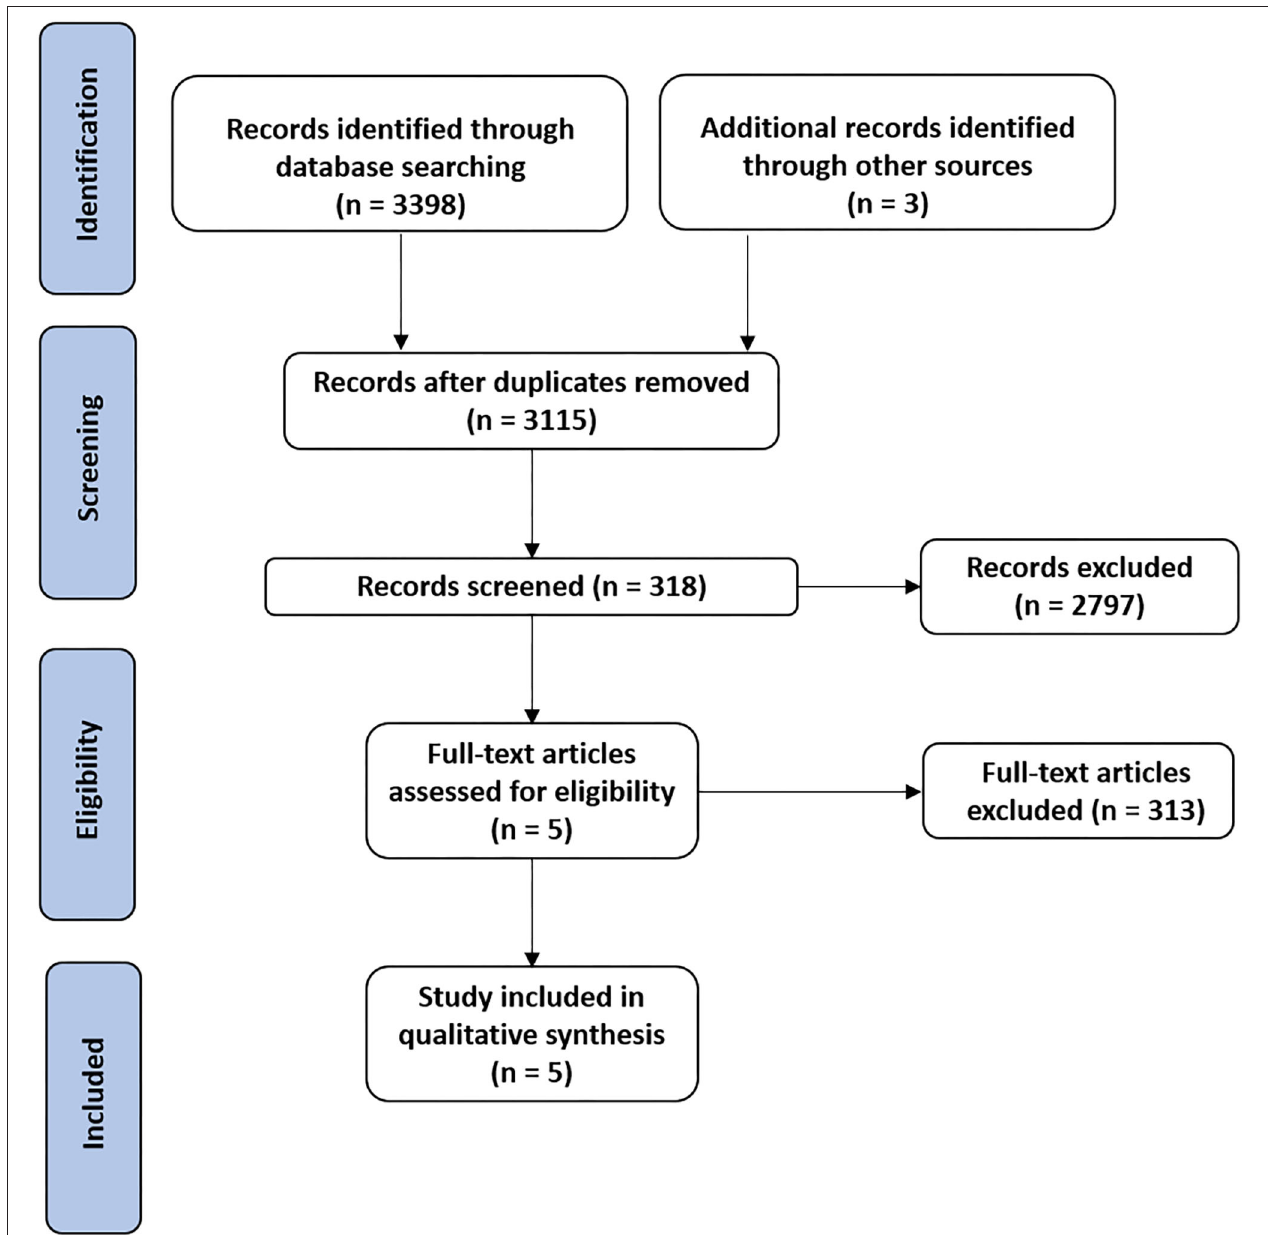
FIGURE 1 | PRISMA flow-diagram showing the selection of the included studies.